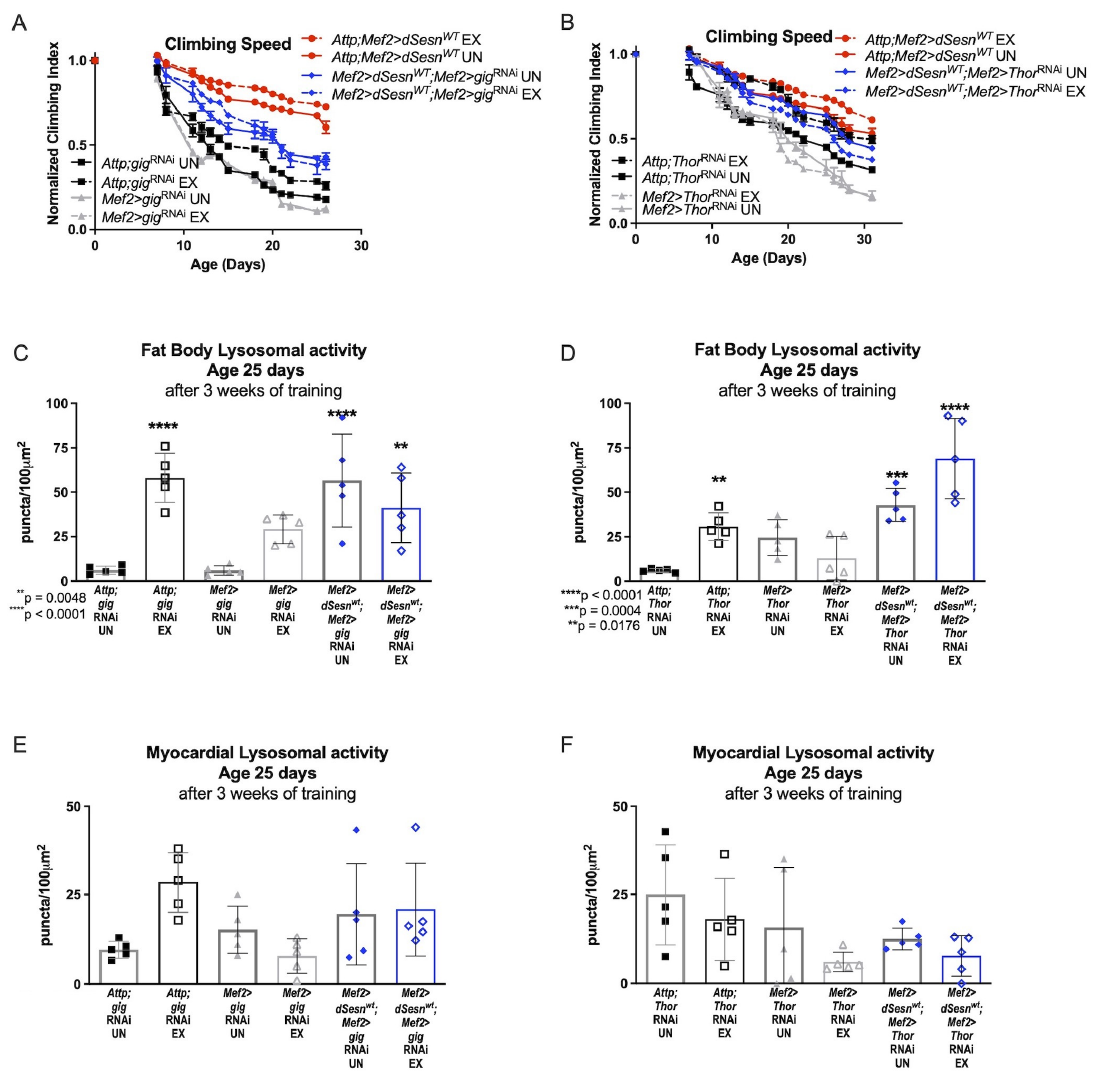
Figure 5. Neither TSC-2 nor 4eBP are required for climbing speed and lysosomal adaptations conferred by Sestrin. ( A ) Exercised flies expressing muscle specific RNAi against TSC-2 ( Mef2 > gig RNAi) do not improve climbing speed (2-way ANOVA, exercise effect, p ≥ 0.6037, but dSesn expression ( Mef2 > dSesn WT ; Mef2 > gig RNAi flies) rescues climbing speed (2-way ANOVA, p ≤ 0.0283). ( B ) Flies expressing muscle specific RNAi against 4eBP ( Mef2 > Thor RNAi flies) have low climbing speed and do not improve climbing speed with exercise (2-way ANOVA, exercise effect, p ≥ 0.8797, genotype effect, p ≤ 0.0219). Wild-type dSesn expression ( Mef2 > dSesn WT ; Mef2 > Thor RNAi flies) rescues climbing speed (2-way ANOVA, p ≥ 0.2350). Climbing speed experiments performed in triplicate, n ≥ 100 flies. ( C , D ) Fat body Lysotracker staining is higher than controls in both Mef2 > dSesn WT ; Mef2 > Thor RNAi and Mef2 > dSesn WT ; Mef2 > gig RNAi whether exercised or not (ANOVA, p ≤ 0.0048). ( E , F ) Myocardial Lysotracker staining is similar across genotypes independent of exercise and wild-type dSesn expression in flies with muscle specific RNAi against either TSC-2 or 4eBP. Lysotracker staining n = 5, performed in duplicate or triplicate. Asterisks represent significant post-hoc comparisons from ANOVA. Error bars depict ± SD. EX = cohort after 3 weeks of ramped, daily endurance training. UN = control unexercised flies exposed to identical training environment without